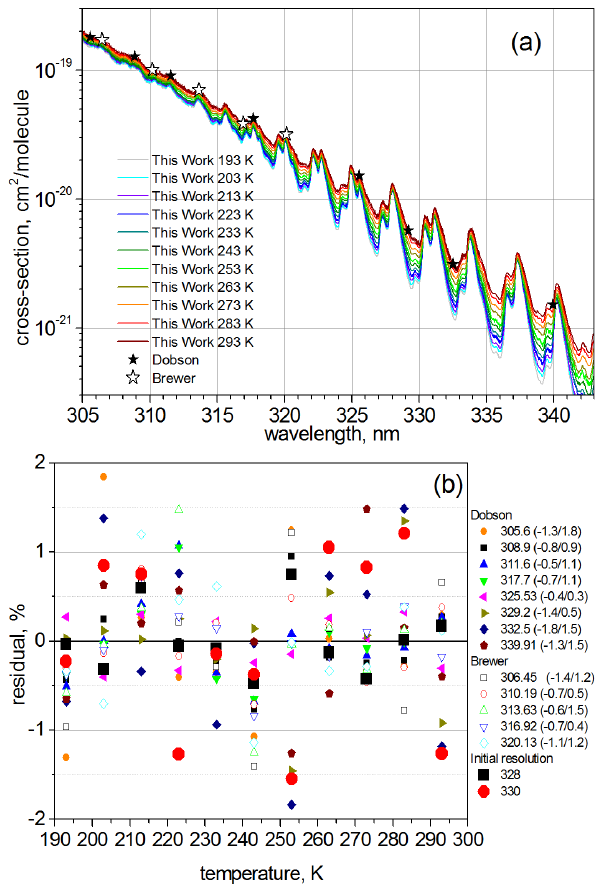
Fig. 4. Temperature dependence of the ozone absorption cross- sections: (a) ozone cross-section data in the Huggins band as mea- sured in this study; (b) residuals from the polynomial fit for the tem- perature dependence in the Huggins band. Small closed and open symbols – Dobson and Brewer spectral channels respectively; big closed squares and circles – data at 328nm and 330nm. Numbers in brackets represent the maximal deviations.